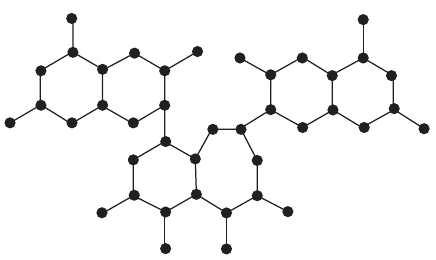
Figure 10: Molecular graph of theaflavin. Table 2: COVID-19 drugs and their physicochemical